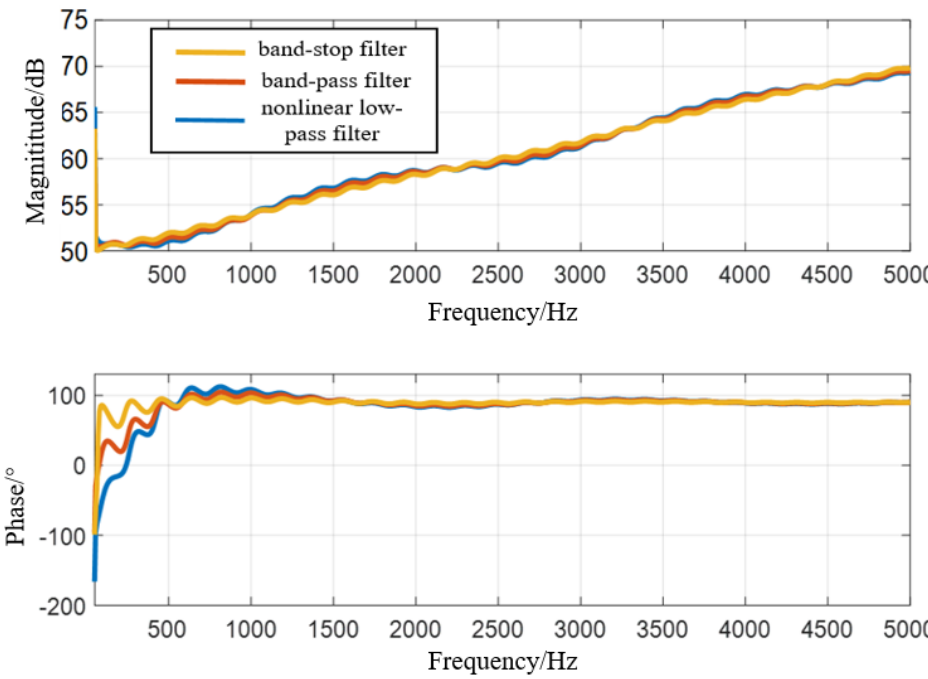
Figure 17. MMC impedance characteristics using different filters.